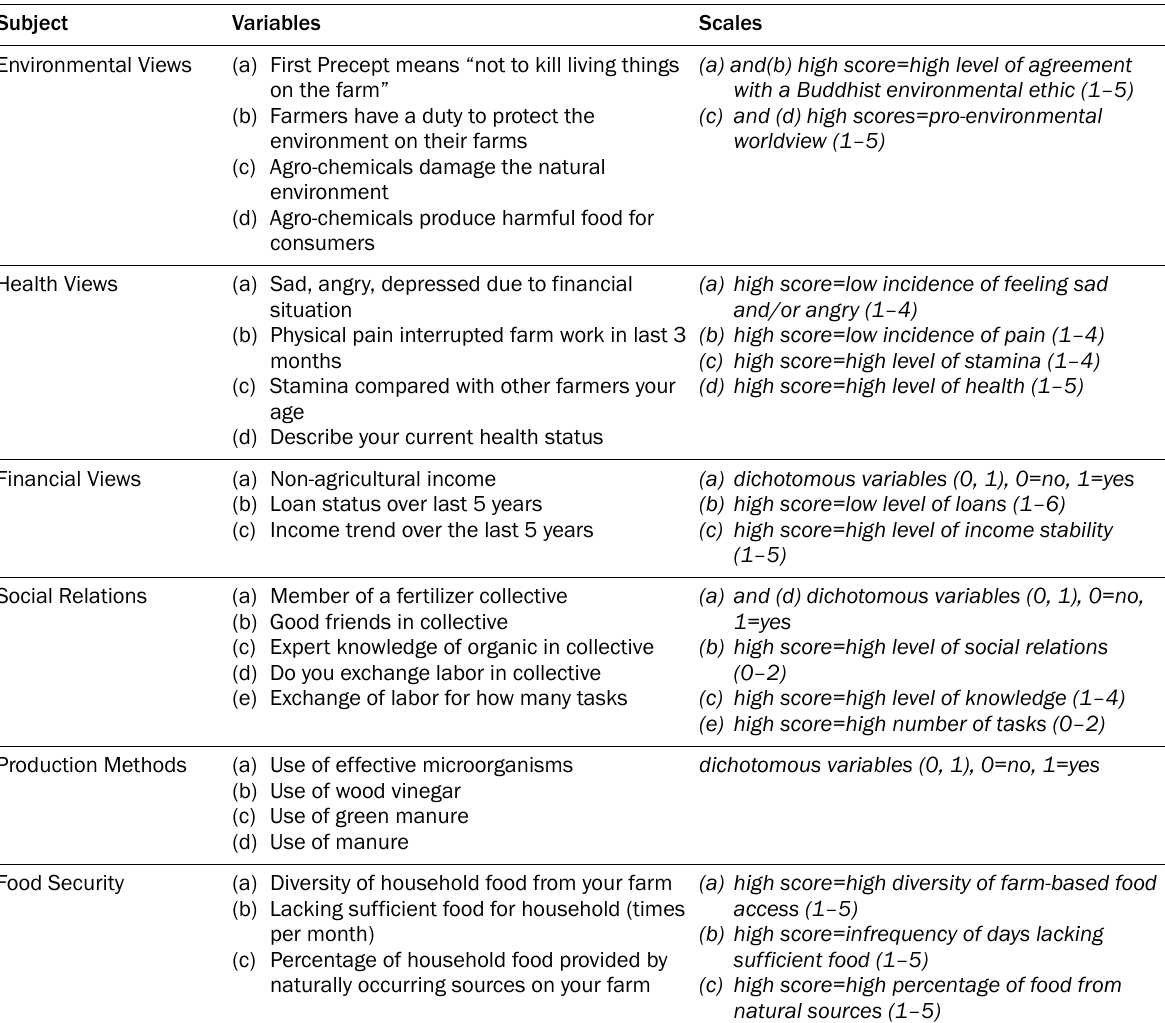
Table 1. Key Categories, Related Questions, and